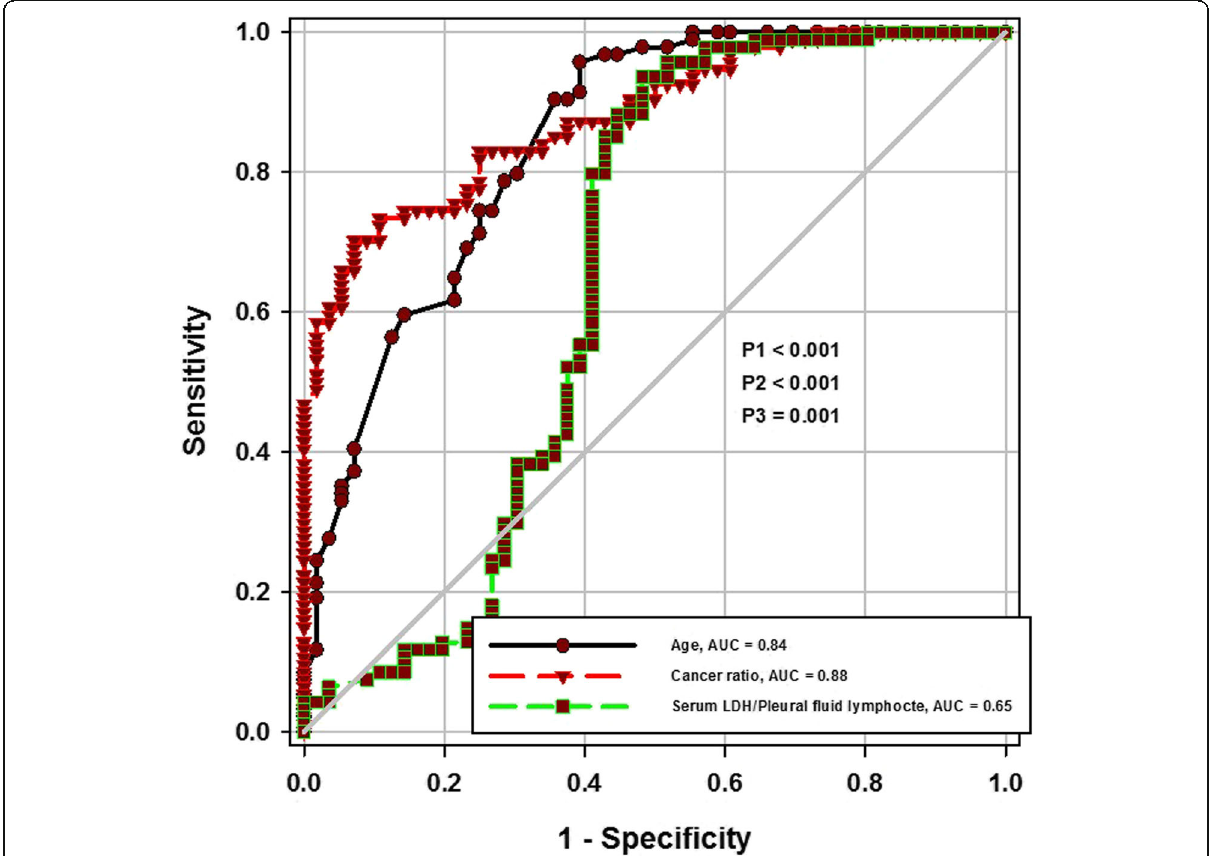
Fig. 1 ROC curve for age, cancer ratio and serum LDH to pleural fluid lymphocyte count